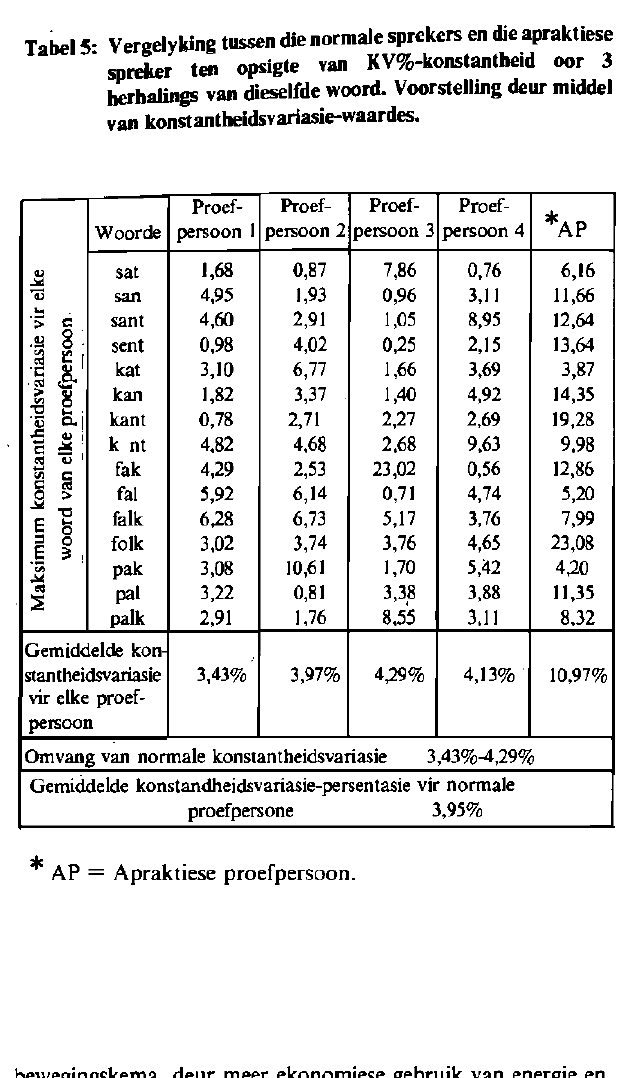
Omvang van KV- Gemiddelde KV- KV-persentasie persentasie by persentasie vir die by die apraktiese normale sprekers normale sprekers